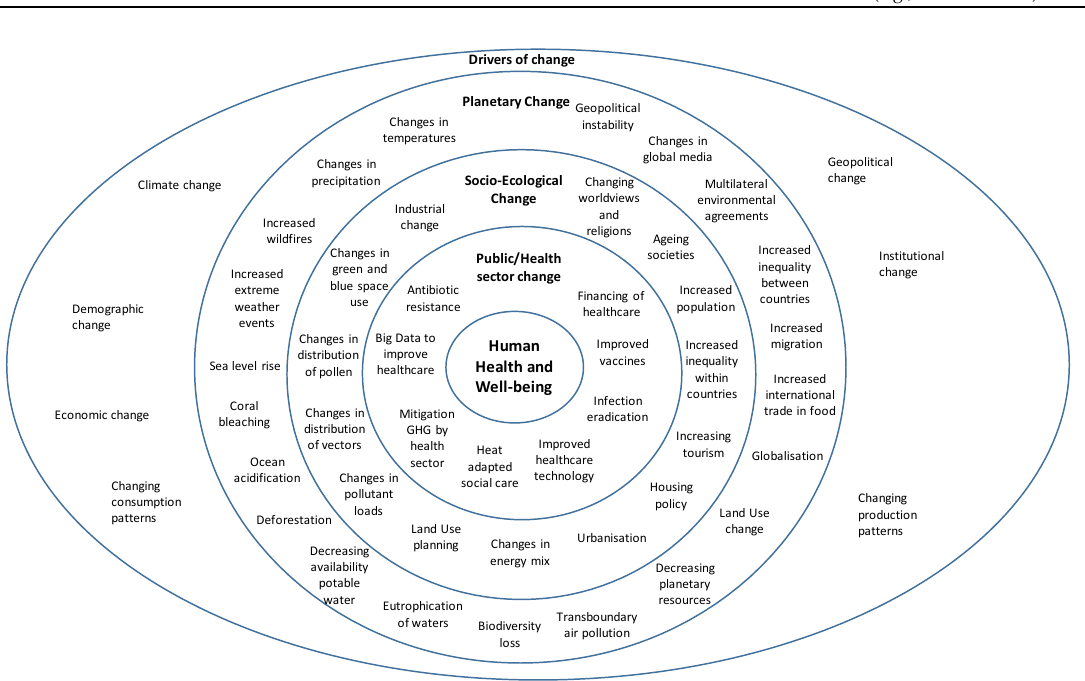
Figure 1. Environmental Change and Health: Global, Socio-ecological and Public/Health Sector changes that impact on human health and well-being.